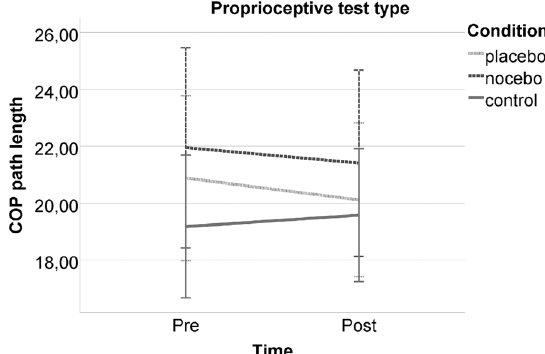
Fig. 3 Postural stability performance of the experimental groups pre- and post-intervention in the proprioceptive test type. Note: The error bars reflect 95% CI